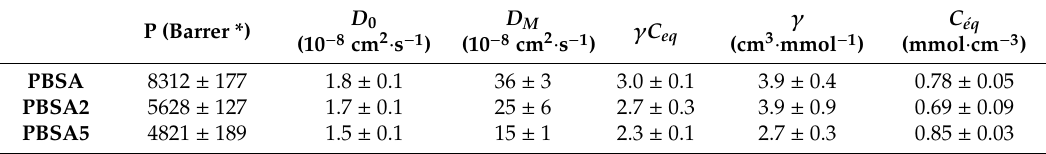
Table 3. Water permeation parameters for the PBSA, PBSA2 and PBSA5 films. P (Barrer